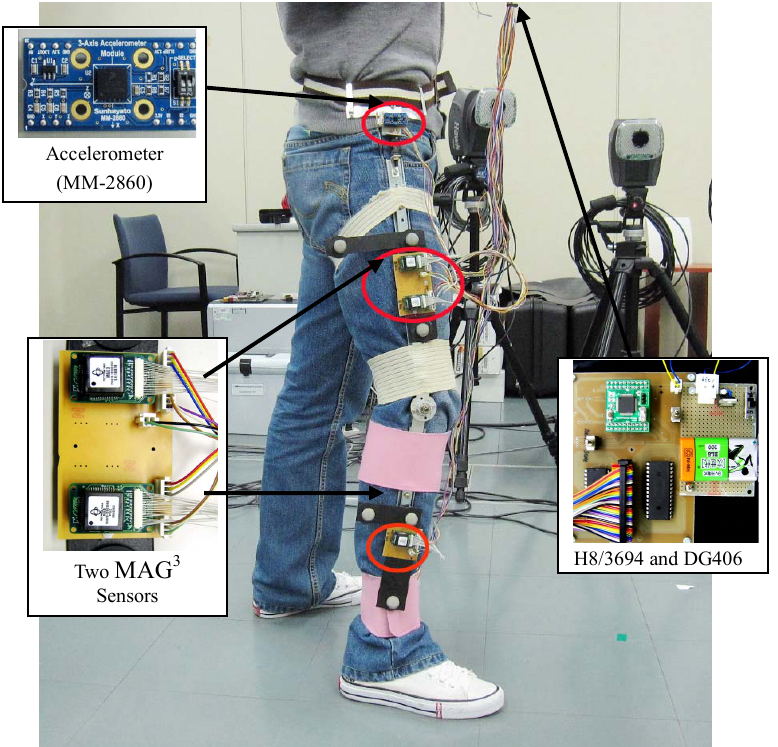
Fig.5 Experiment with the wearable sensor system in the working space of the optical motion